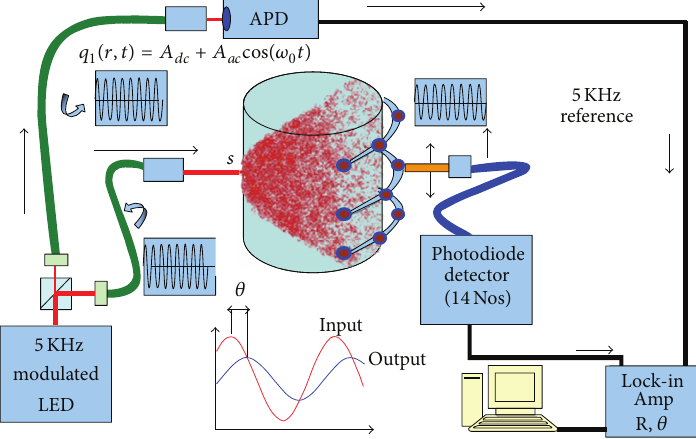
Figure 2: System